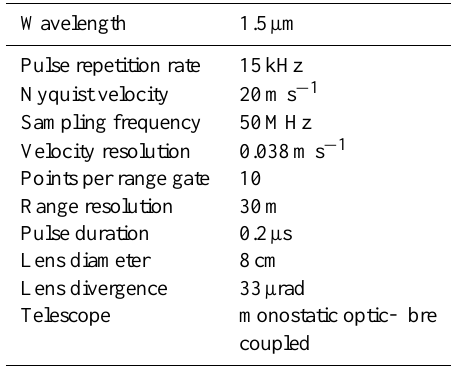
Table 1. Doppler lidar